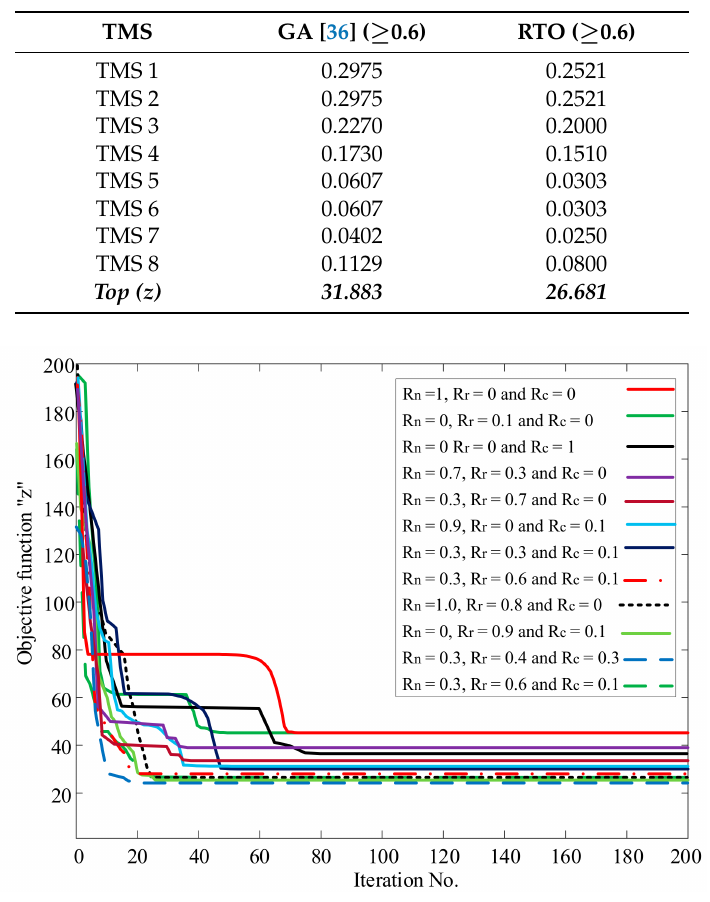
Figure 6. Convergence characteristic of Case 1 for different adjustable parameters to the RTO